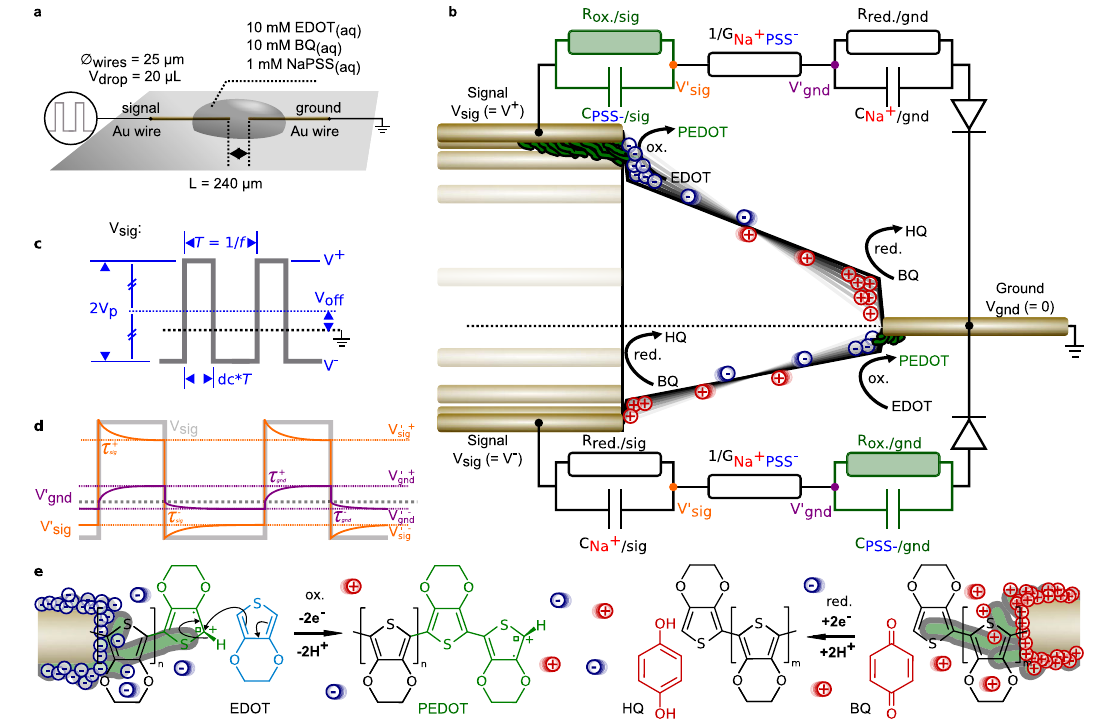
Fig. 1 Working principle for the growth of conducting-polymer dendrites under pulse-voltage polarization. a Experimental setup to grow dendritic PEDOT on free-standing gold (Au) wires of 25 μ m diameter, separated by a gap of L = 240 μ m, polarized under square voltage on the signal wire, and the other wire grounded, in an aqueous electrolyte containing 10 mM of EDOT, 10 mM of BQ and 1 mM of NaPSS, as a V drop = 20 μ L drop. b Generic equivalent circuit of the electrochemical system, depicting the dynamics of the bias voltage across the gold wires, that yield to various potential dependent kinetics for the ion drifts thanks to the different RC circuit elements involved in the electrochemical system. c De fi nition of the V sig pulse-voltage parameters investigated in this study, in terms of peak voltage amplitude V p , voltage offset V off , frequency f , duty cycle dc, anodic polarization V + , cathodic polarization V − and period T . d Voltage diagram displaying the ion dynamics, inducing a time-dependent voltage-drop across the electrolyte, that results in different growth modes for the electropolymerized PEDOT dendrites. e Faradaic (redox) and Non-Faradaic (capacitive) processes occurring at both anodic and cathodic dendritic electrodes upon V sig